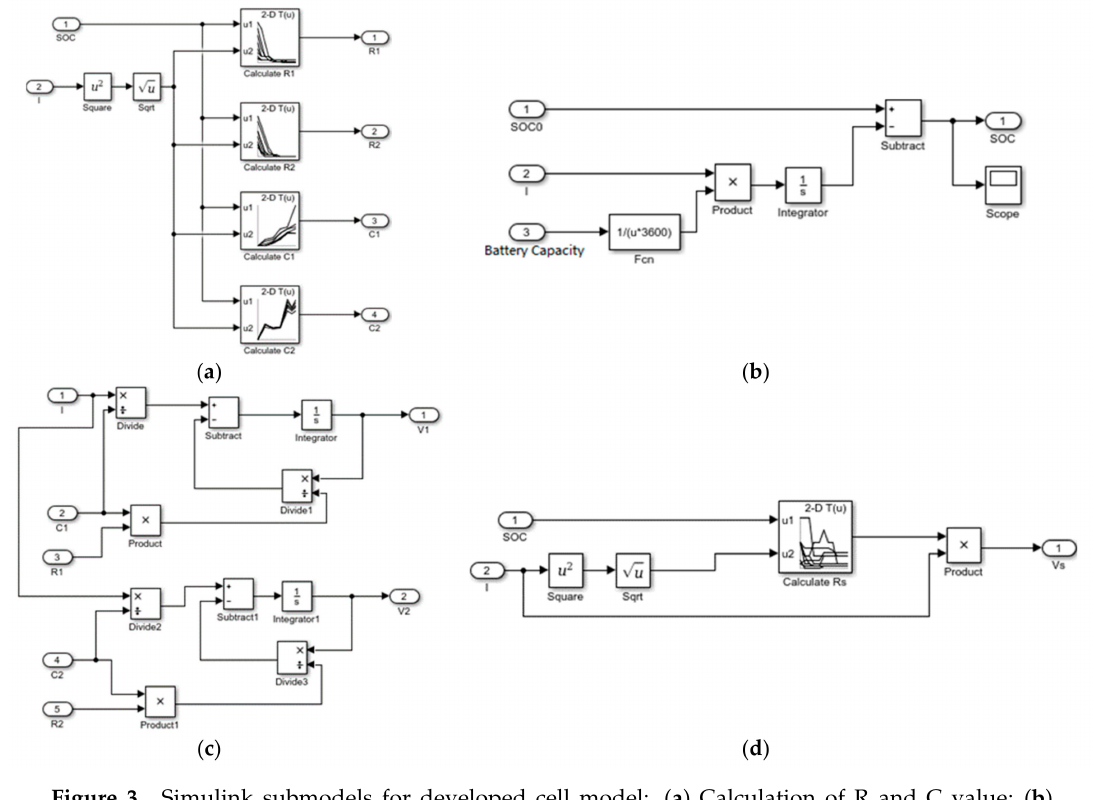
Figure 3. Simulink submodels for developed cell model: ( a ) Calculation of R and C value; ( b ) Calculation of SOG; ( c ) Calculation of RC parallel voltage; ( d ) Calculation of V S